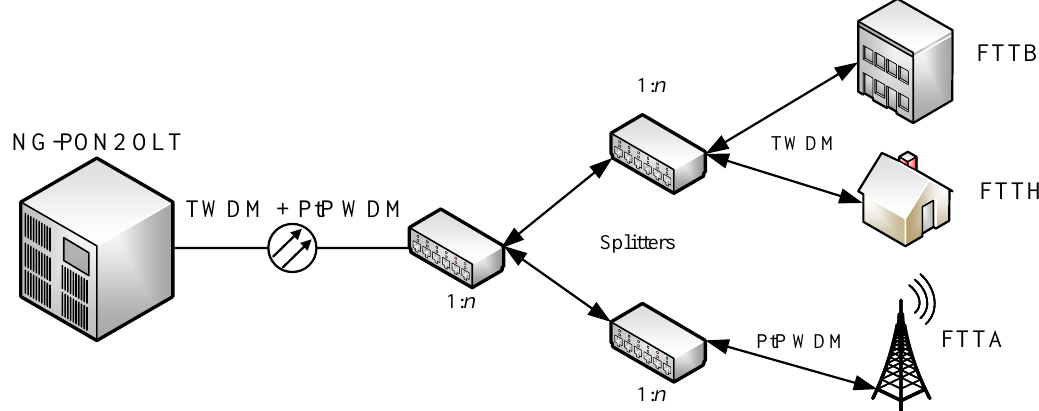
Figure 8. TWDM and point to point wavelength division multiplex (PtP WDM) usage